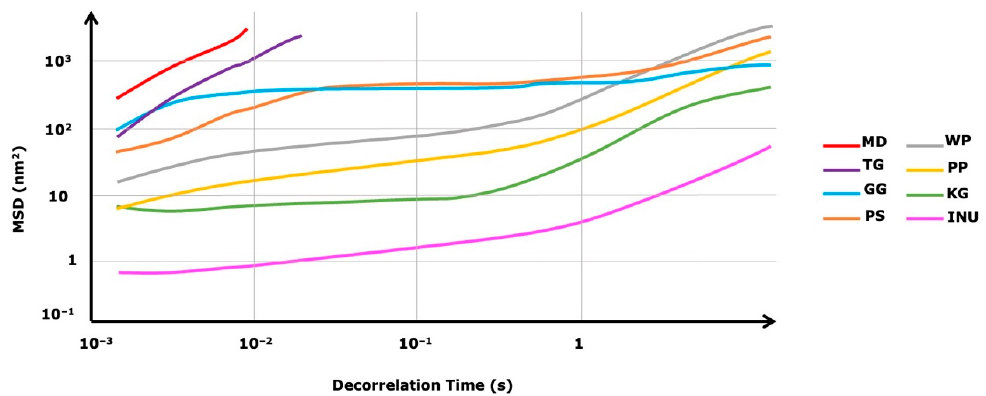
Figure 2. Selected mean square displacement MSD of the analyzed biopolymers, as a function of decorrelation time.